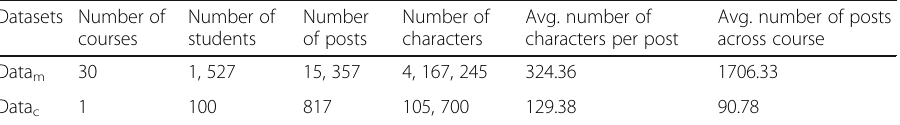
Table 3 Basic statistics of the post datasets Datasets Number of